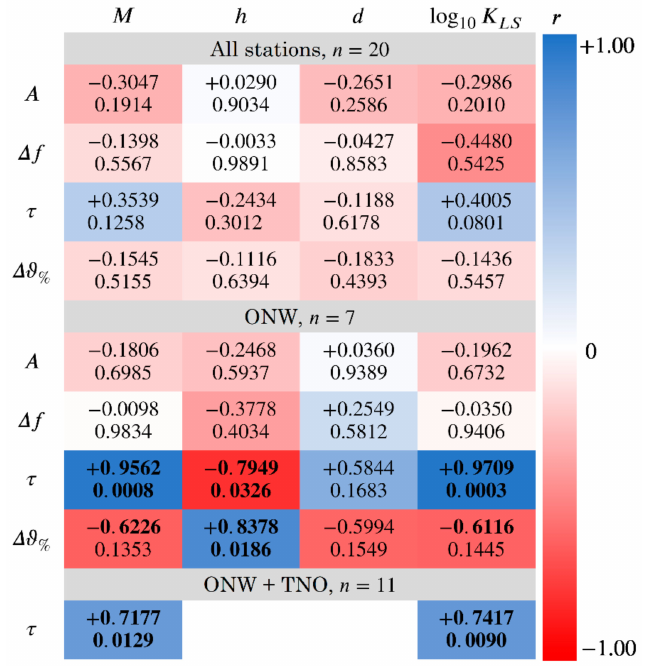
Figure 10. Heat map of r (the first number in each box) for each property–characteristic pair using three data points: all stations, ONW station and ONW+TNO stations. Corresponding p -values are included (the second number). The values of | r | ≥ 0.60 and p < 0.05 are